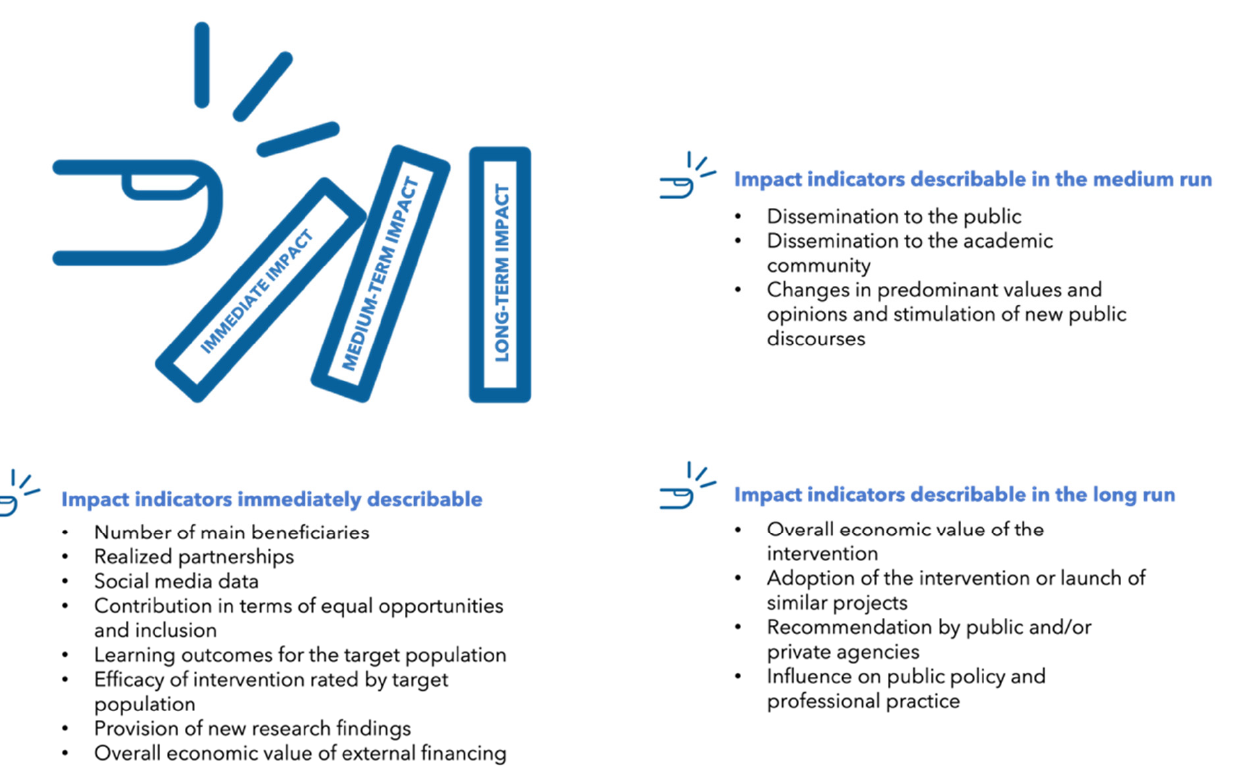
Figure 3. Immediate-, medium-, and long-term impact indicators.